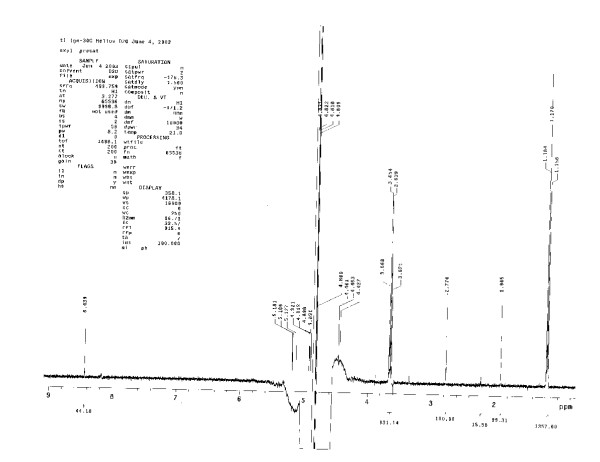
1H-NMR Spectrum of Ignatia-30 C (Helios): expansion of 1 – 9 ppm region. Key to peaks [position – interpretation]: 1.17 – ethanol, methyl triplet; 1.47 – artifact (R4); 1.90 – acetate; 2.22 – acetone; 2.77 – C6H8O2 (1,4-cyclohexanedione marker); 3.35 – methanol; 3.60 – artifact (C1); 3.65 – ethanol, methylene quartet; 3.88 – artifact (R5); 4.3 to 5.3 – water (presaturated); 8.17 – artifact (C2); 8.44 – formate; 11.53 (not shown) – artifact (C3).